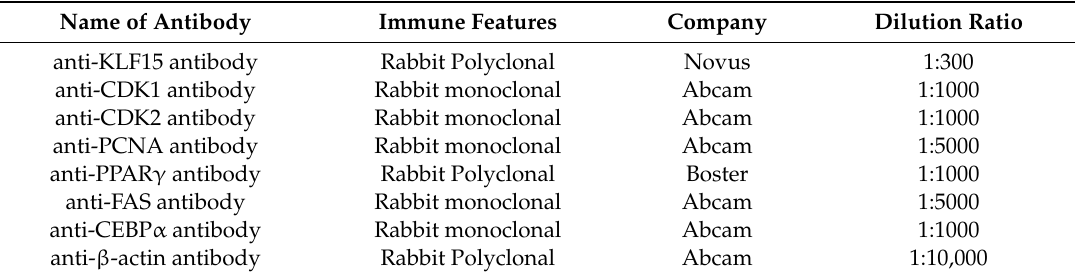
Table 1. Antibody